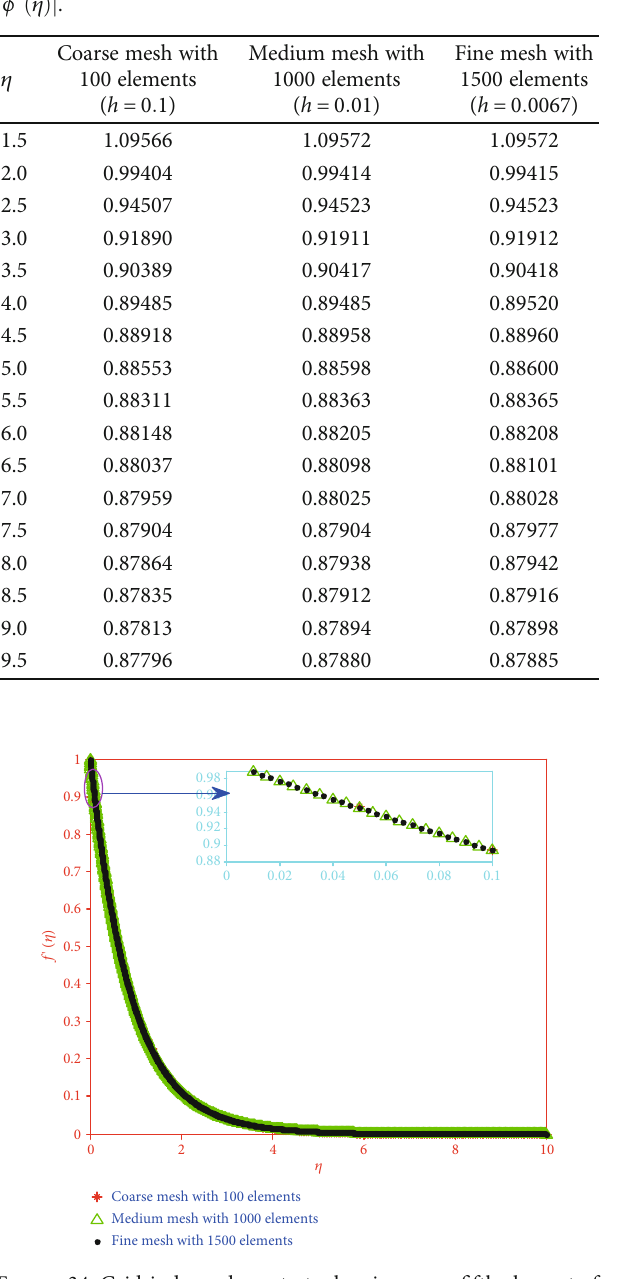
Figure 34: Grid-independence tests showing every fi fth element of the mesh for velocity pro fi le.